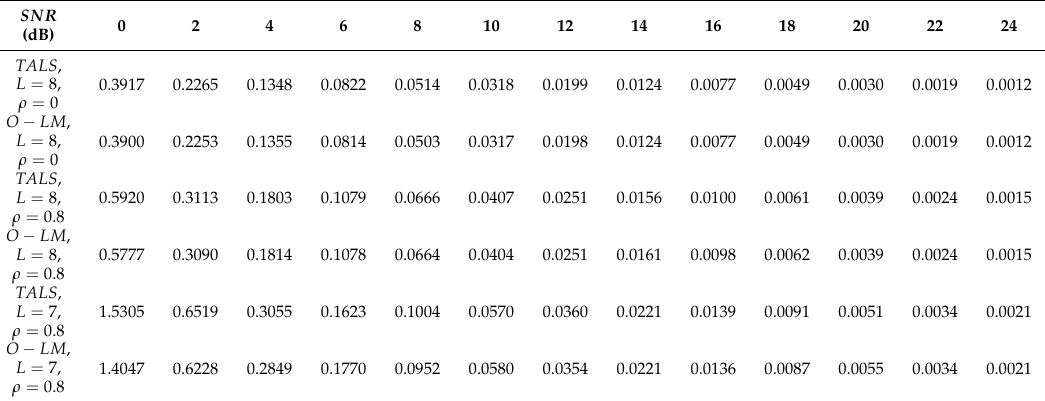
Figure 6. The mean processing times required in T-ALS and O-LM algorithms versus SNR. Table 1. NMSE of the T-ALS and O-LM